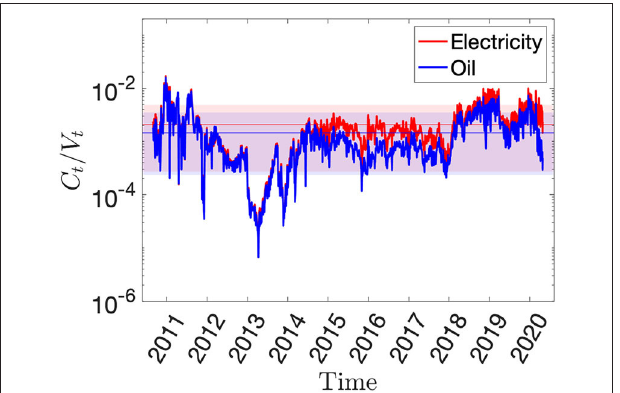
t / V t on daily basis. The band is the region between the first and tenth decile and the center line is the mean value, which is 0.15% for oil and 0.21%.